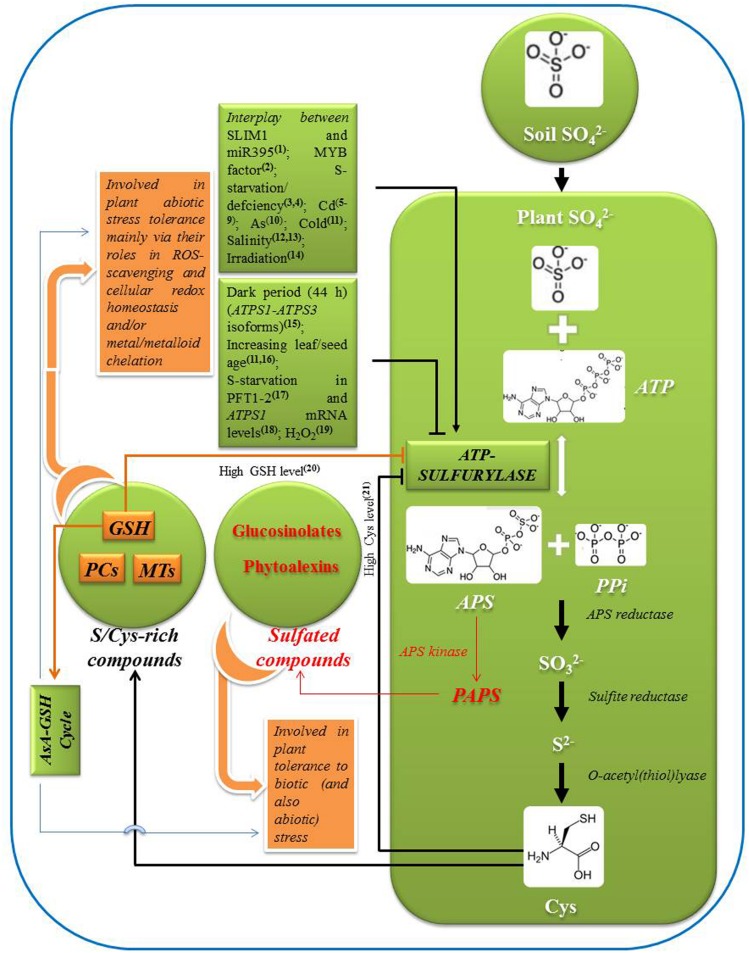
Schematic representation of pathway of sulfate assimilation, reaction catalyzed by ATP-sulfurylase (ATP-S), and its regulation by major factors. Role of ATP-S in plant stress tolerance through sulfur/cysteine rich and sulfated compounds is outlined. Positive and negative regulation of ATP-S is indicated by arrows and blunt ends, respectively, [1Kawashima et al. (2011); 2Yatusevich et al. (2010); 3Hopkins et al. (2004); 4Schiavon et al. (2007); 5van de Mortel et al. (2008); 6Guo et al. (2009); 7Gill et al. (2012); 8Bashir et al. (2013); 9Asgher et al. (2014); 10Leao et al. (2014); 11Phartiyal et al. (2006); 12Ruiz and Blumwald (2002); 13Nazar et al. (2011); 14Passera et al. (1989); 15Huseby et al. (2013); 16Rotte and Leustek (2000); 17Takahashi et al. (1997); 18Liang et al. (2010); 19Lappartient and Touraine (1997); 20Lappartient and Touraine (1996); 21Vauclare et al. (2002)]. (APS, adenosine 5′-phosphosulfate; Cys, cysteine; AsA, ascorbate; GSH, reduced glutathione; PCs, phytochelatins; MTs, metallothioneins; ROS, reactive oxygen species).